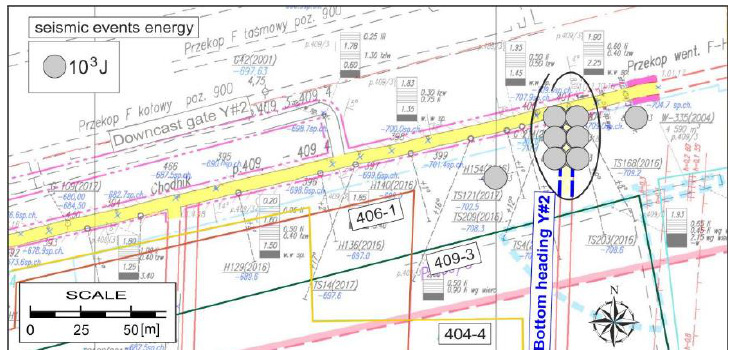
Figure 7. Distribution of seismic events with energy E ≥ 10 3 J during the drifting of bottom heading Y#2.